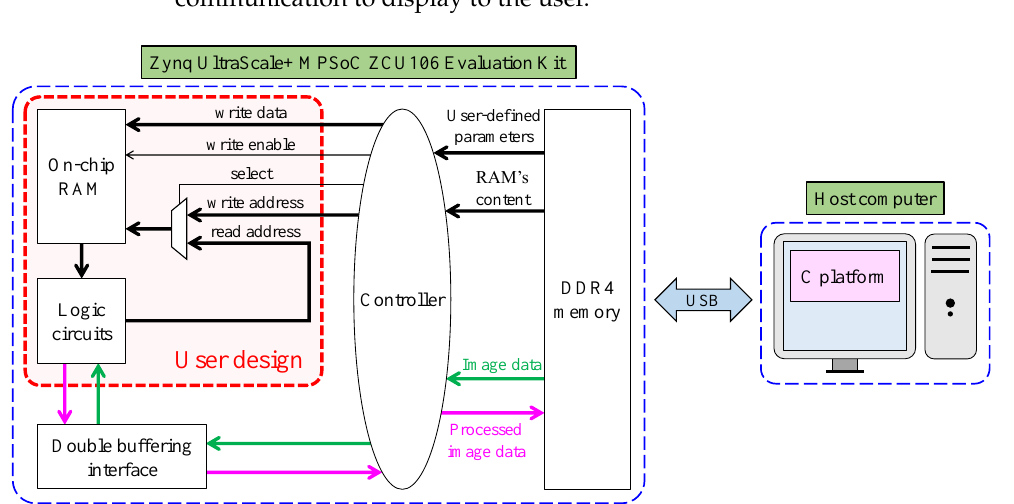
Figure 8. Block diagram of the hardware verification. The top-left portion is the RAM’s content updating scheme for run-time